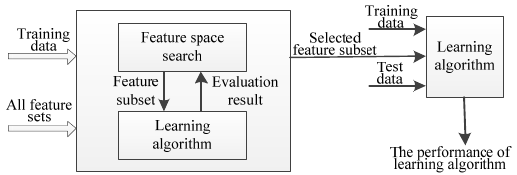
Figure 7. The process flow of wrappers for the feature subset selection.